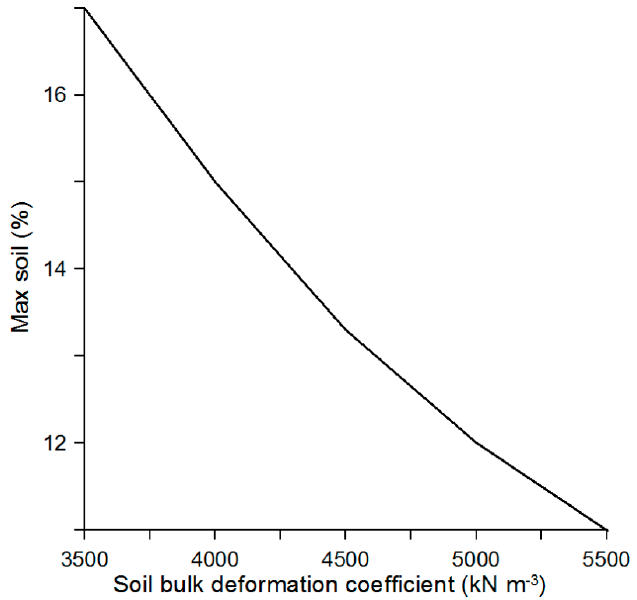
Figure 5. Dependence on the maximum tractor’s wheels slip (cid:2012) (cid:3040)(cid:3028)(cid:3051) from the soil bulk deformation coefficient (cid:1863) (cid:3042) Function (cid:2012) (cid:3040)(cid:3028)(cid:3051) = (cid:1858)((cid:1858) (cid:3038) ) (Figure 4) was obtained at (cid:1843) = 160 kN · m (cid:2879)(cid:2870) , (cid:1844) (cid:3038) = 0.72 m , (cid:1863) = 4000 kN · m (cid:2879)(cid:2871) , and (cid:1858) = 0.08 − 0.20 [22]. Calculation of the equation (cid:2012) (cid:3042) (cid:3038) was conducted at (cid:1843) = 160 kN · m (cid:2879)(cid:2870) , (cid:1844) (cid:3038) = 0.72 m , (cid:1858) (cid:3038) = 0.16 , and (cid:1863) (cid:3042) = 3500 − 5500 kN · m (cid:2879)(cid:2871) .